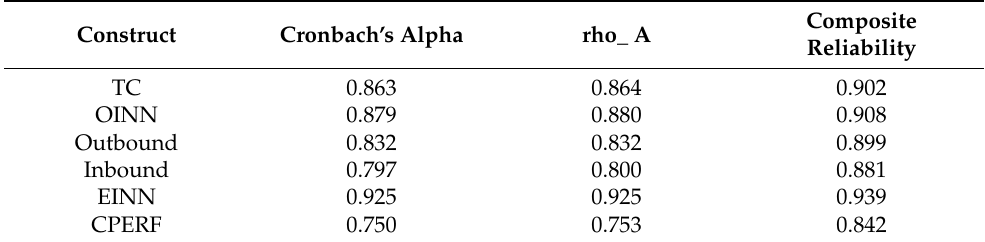
Table 4. Reliability and validity by construct. TC, technological capability. OINN, open innovation; EINN, eco-innovation; CPERF, corporate performance. Construct Cronbach’s Alpha